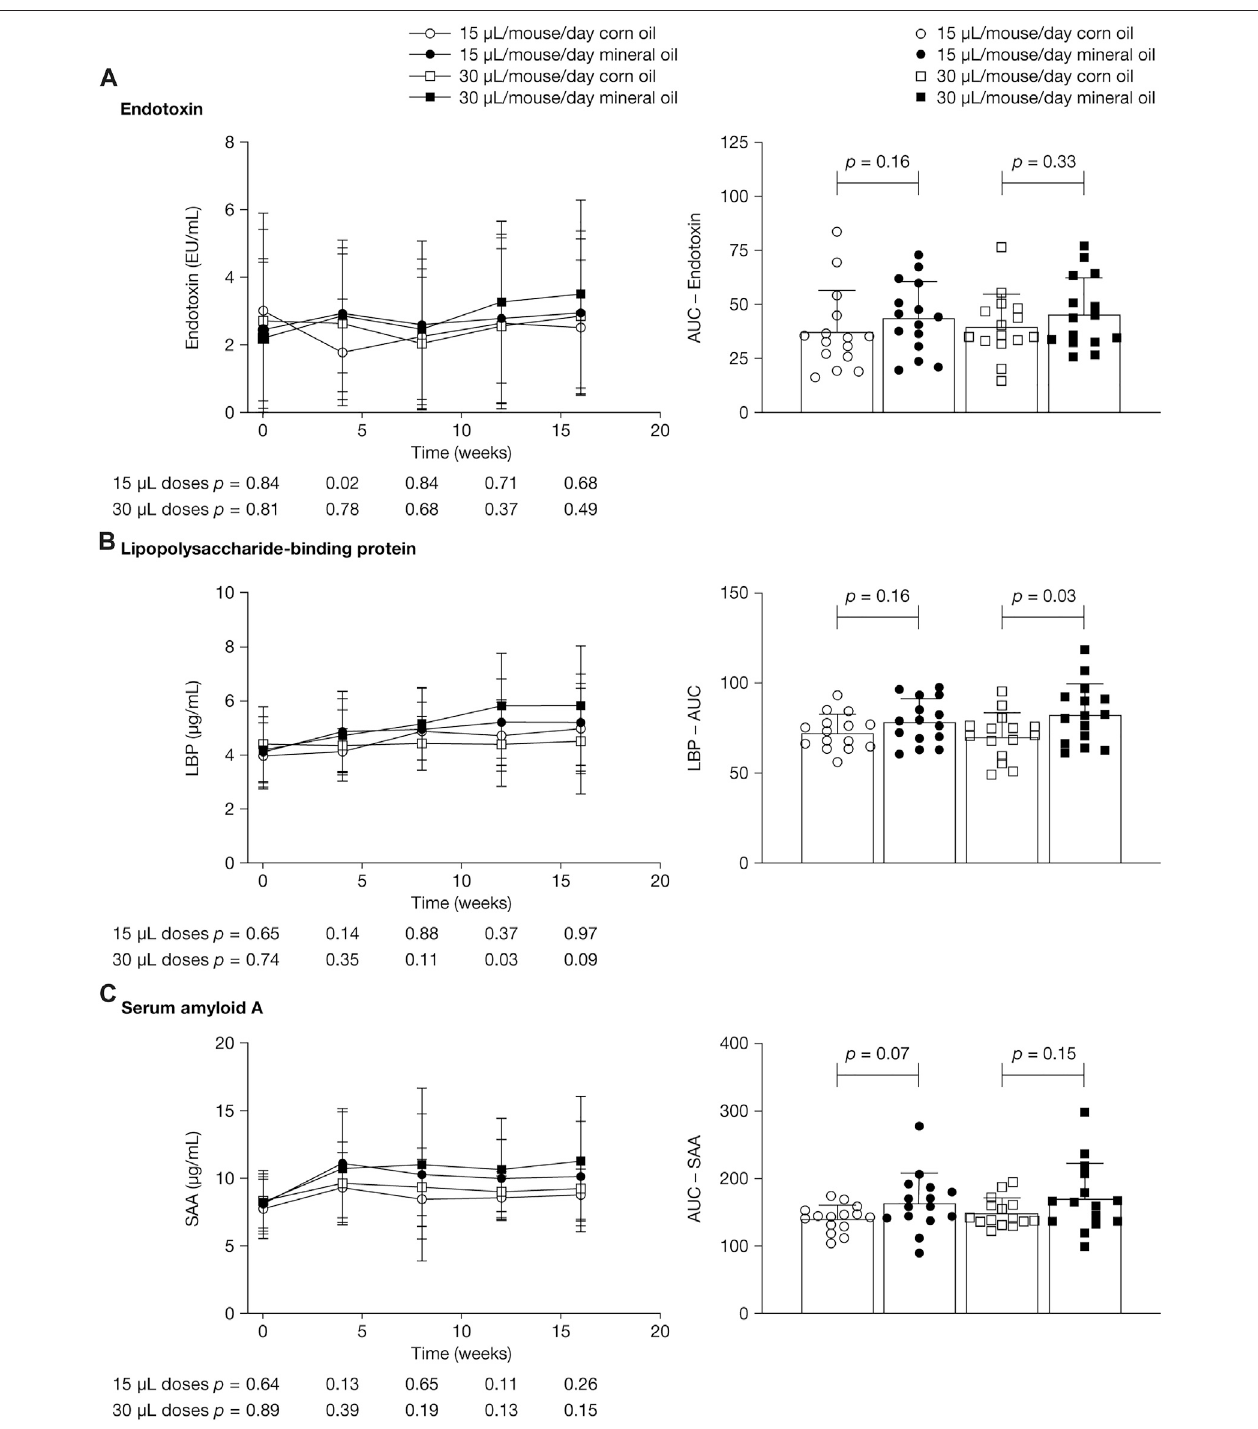
FIGURE2| Mean(SD)plasmaconcentrationsat0,4,8,12,and16 weeks(leftpanels)andareaundertheconcentration – timecurve(rightpanels)for (A) endotoxin, (B) lipopolysaccharide-binding protein, and (C) serum amyloid A. p -values were calculated using independent samples t -test. AUC, area under the concentration – time curve; LBP, lipopolysaccharide-binding protein; SAA, serum amyloid A; SD, standard deviation.